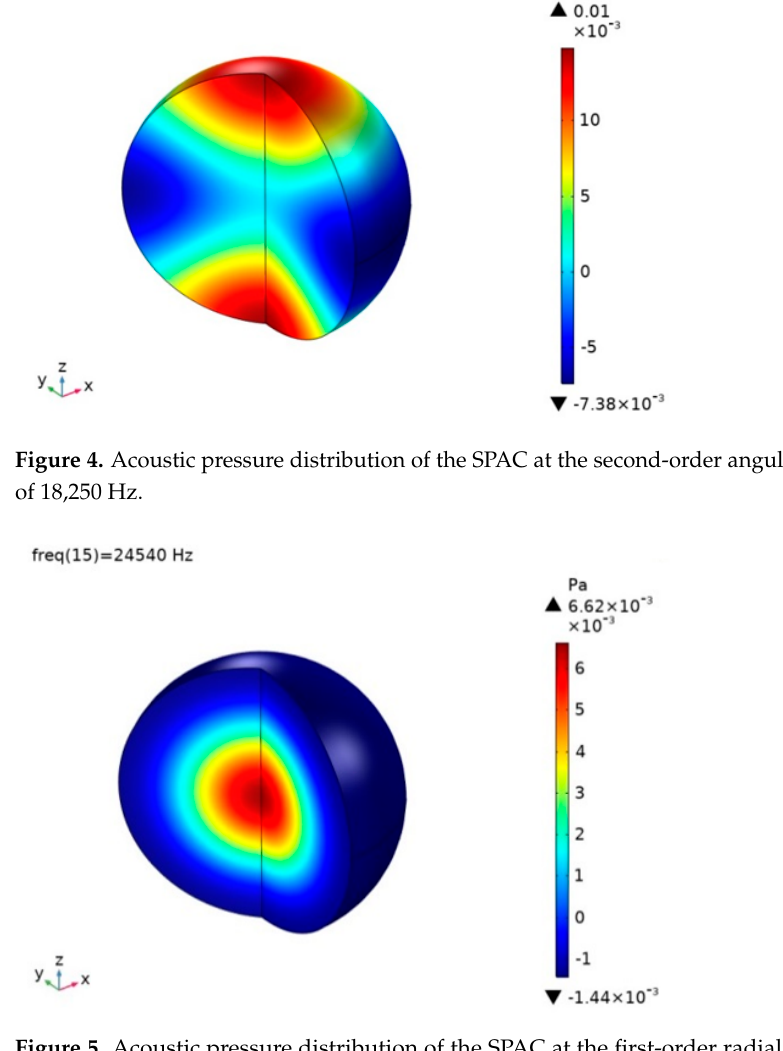
Figure 5. Acoustic pressure distribution of the SPAC at the first-order radial resonance frequency of 24,540 Hz.